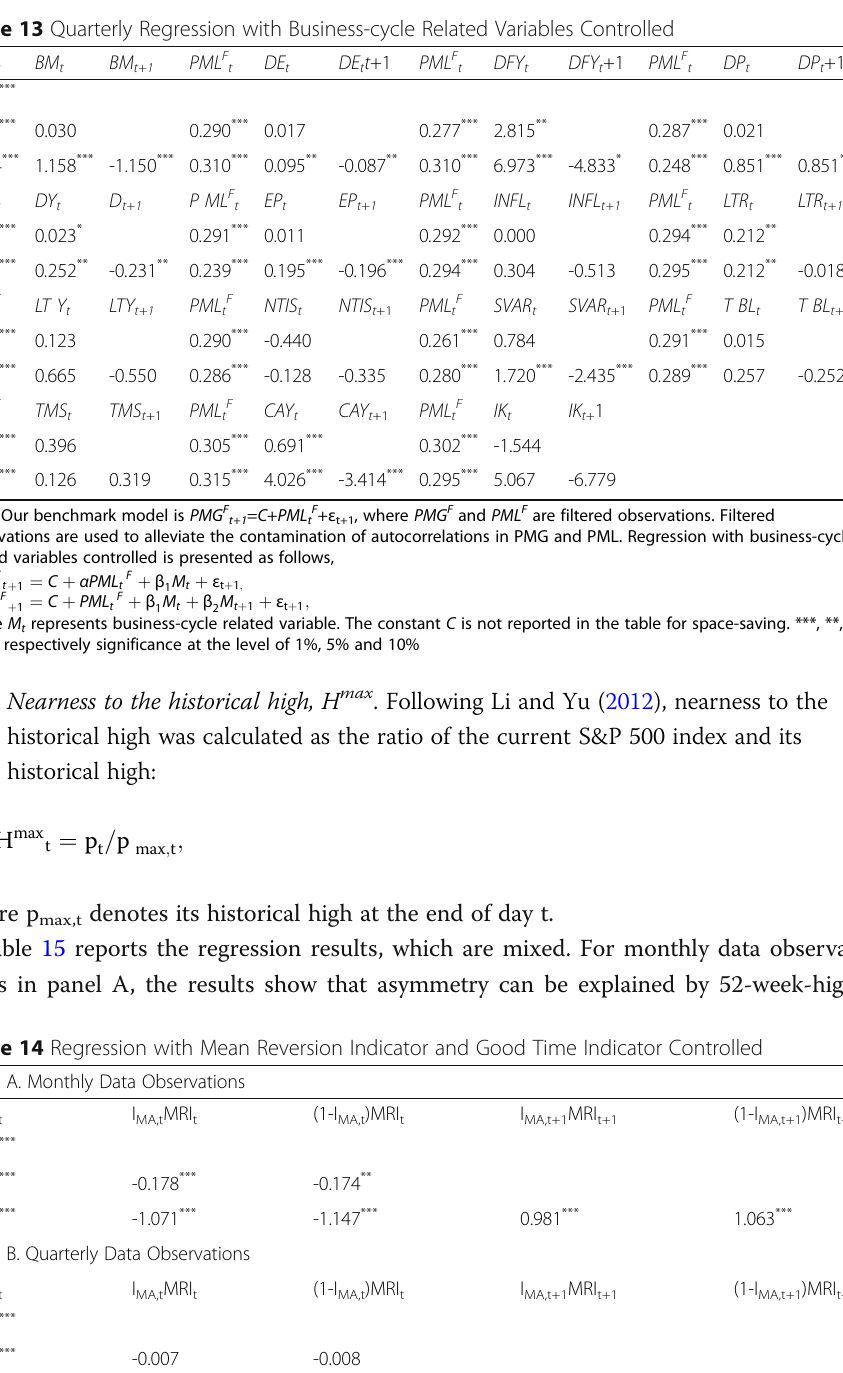
Panel B. Quarterly Data